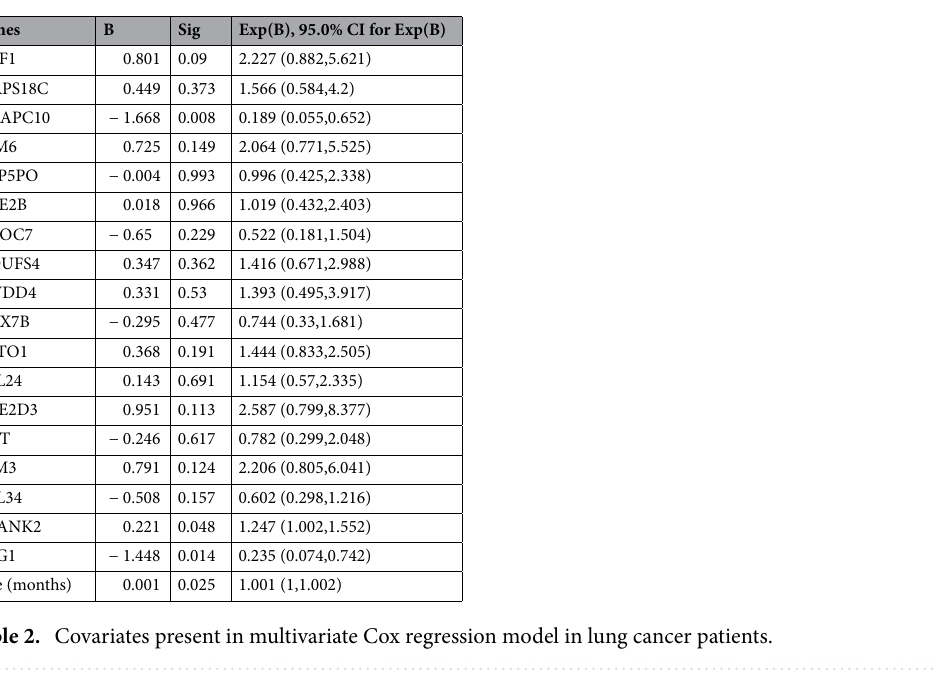
FRG1 and correlated genes do not predict survival in the colorectal cancer. To investigate the prognostic effect of FRG1 using colorectal cancer TCGA-READ (The Cancer Genome Atlas Rectum Adeno- carcinoma) and TCGA-COAD (The Cancer Genome Atlas Colon Adenocarcinoma) datasets, the top 20 FRG1 correlated genes (Supplementary Table S2) were added (r s ≥ 0.964) in the multivariate cox regression model (Supplementary Table S3). Models with all the 20 genes and any other combination of genes didn’t show sig- nificant effect of FRG1 on the OS of the colorectal cancer patients. The hazard ratio of FRG1 was 0.478 (95% CI 0.081–2.824, p = 0.415) for colorectal cancer patient’s death. Next, to determine the effect in the multigene model, the patients were divided into the low-risk (n = 306) and high-risk groups (n = 305), based on the median risk score. The AUC for this risk model was 0.604 (Supplemen- tary Fig. S3). A significant (p = 0.0001) difference in OS was observed between the two groups (Fig. 5A). Com- parison of FRG1 mRNA expression between the high-risk and low-risk groups showed significantly (p < 0.0001) higher expression in the low-risk group (Fig. 5B).